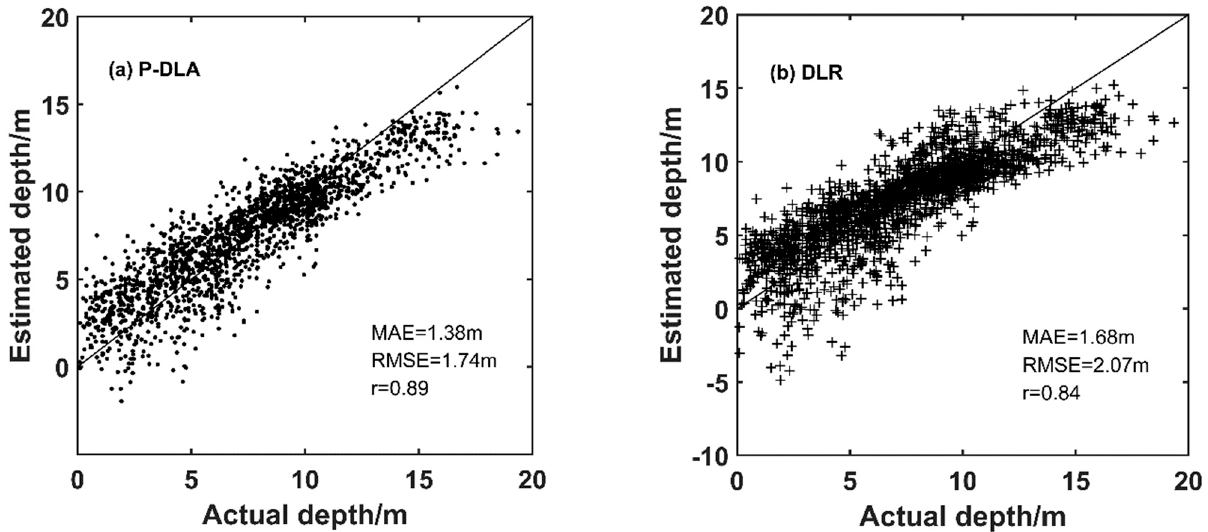
Remote Sens. 2021 , 13 , x FOR PEER REVIEW 16 of 22